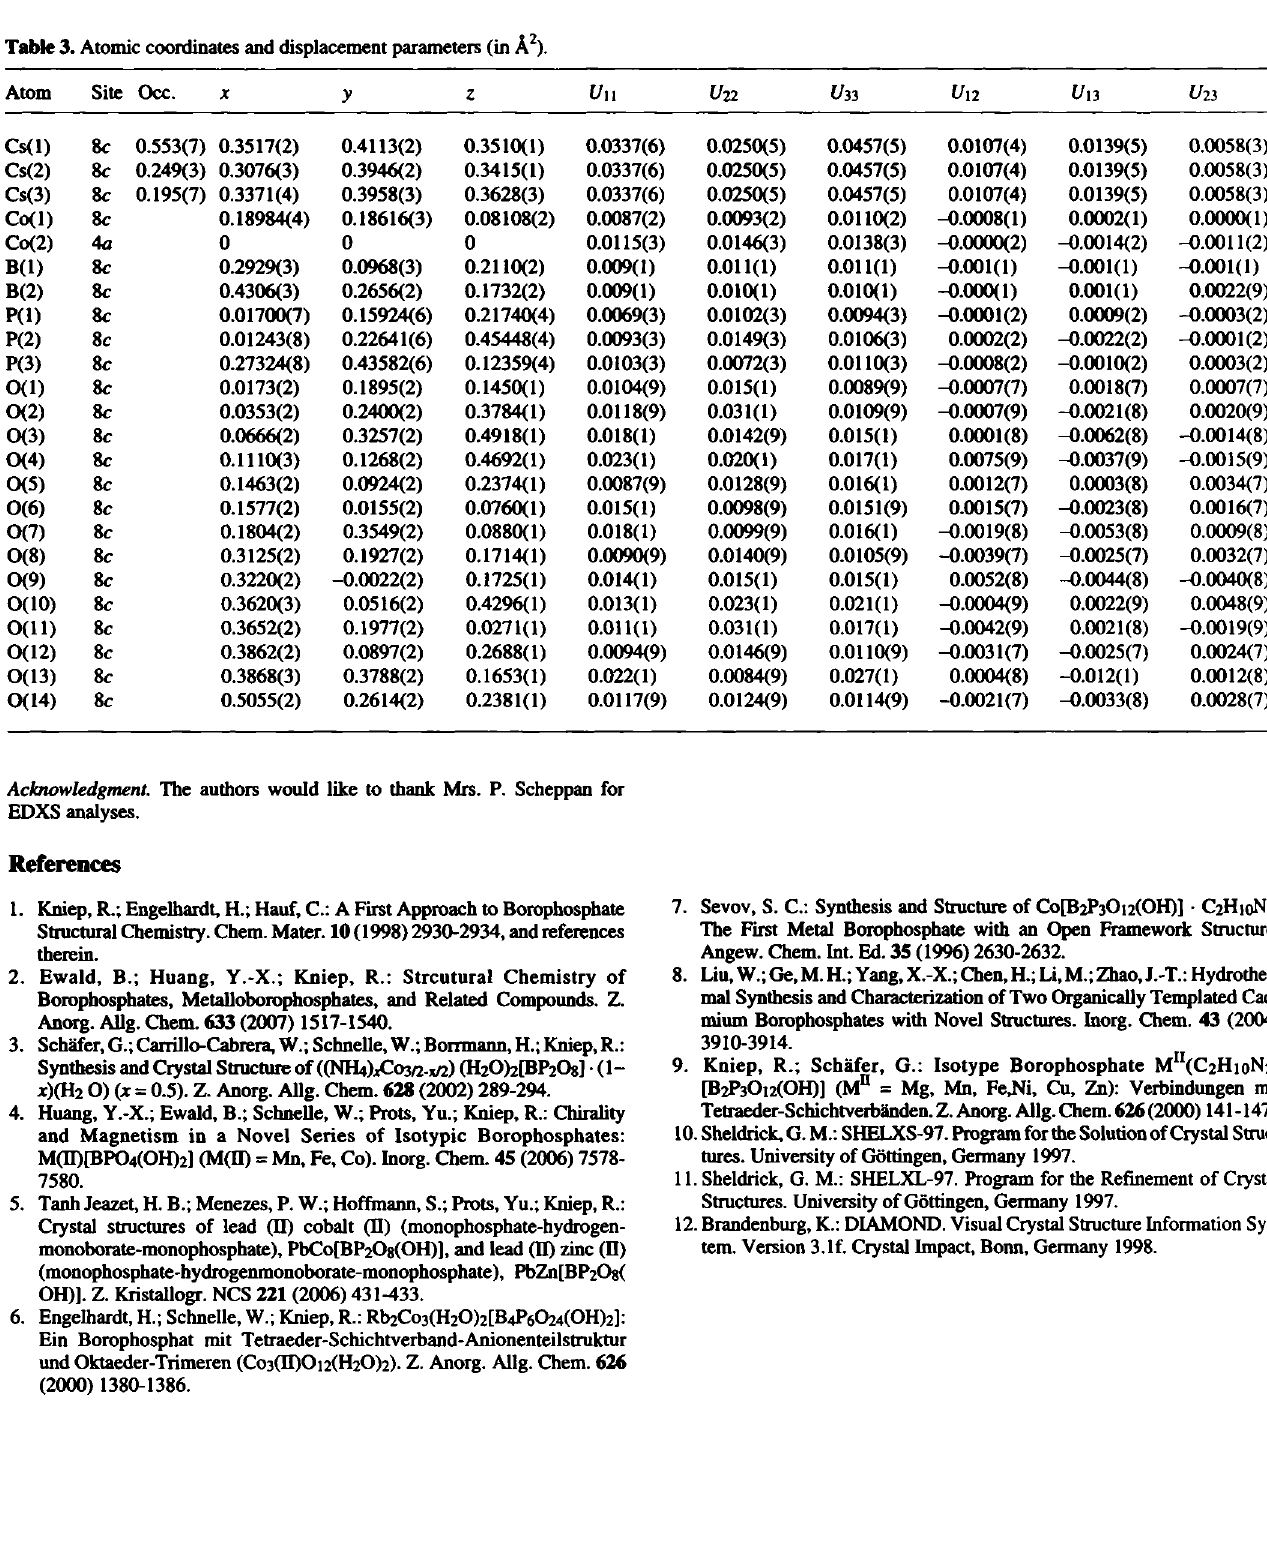
Table 3. Atomic coordinates and displacement parameters (in Â 2